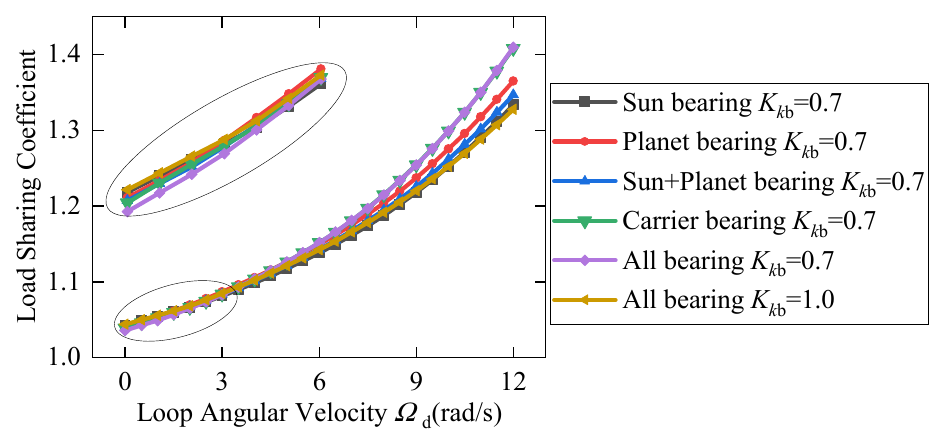
Figure 21. The effect of reducing the stiffness of each bearing on the LSC at different LAV. The variation trend in LSC versus bearing stiffness under different LAV is shown in Figure 22. Figure 22a shows that the LSC increases with the enhancement of the stiffness of the sun gear bearing, and the change rate of the curve slightly increases with the increase in the LAV.